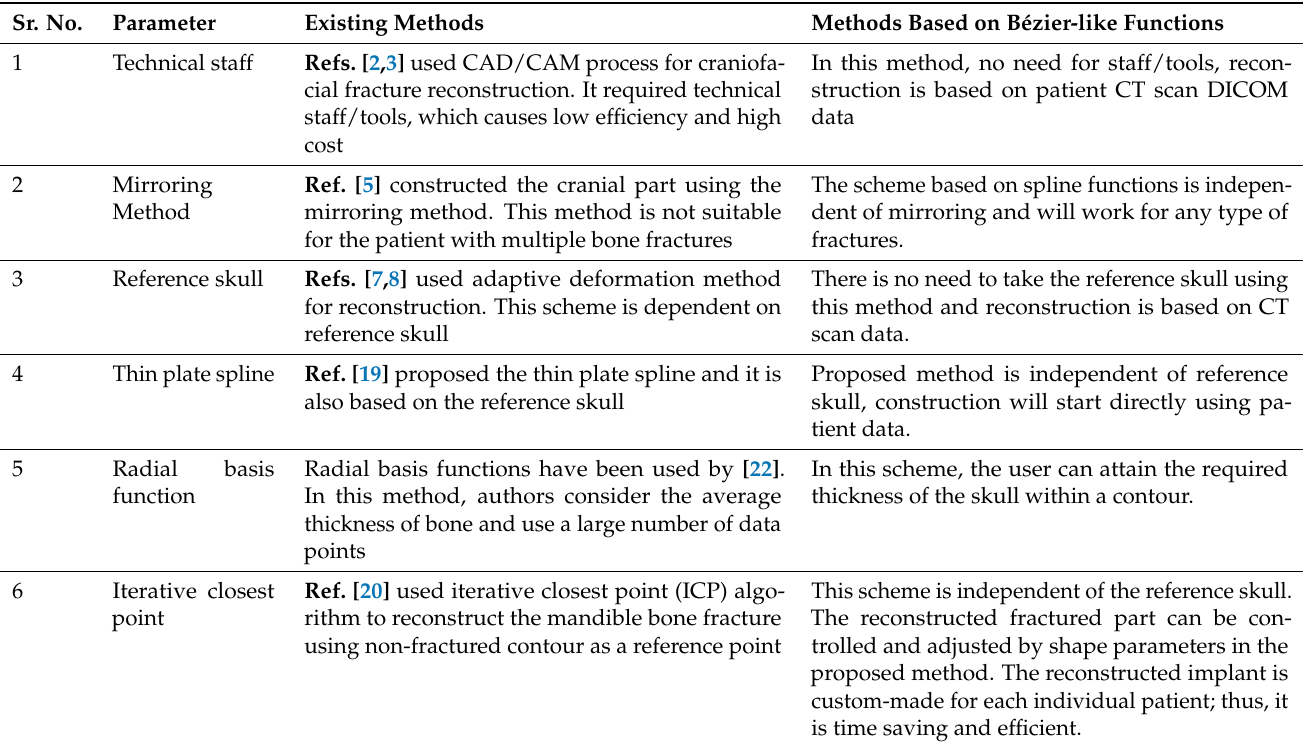
Table 1. Comparison of existing techniques and techniques based on spline curves.